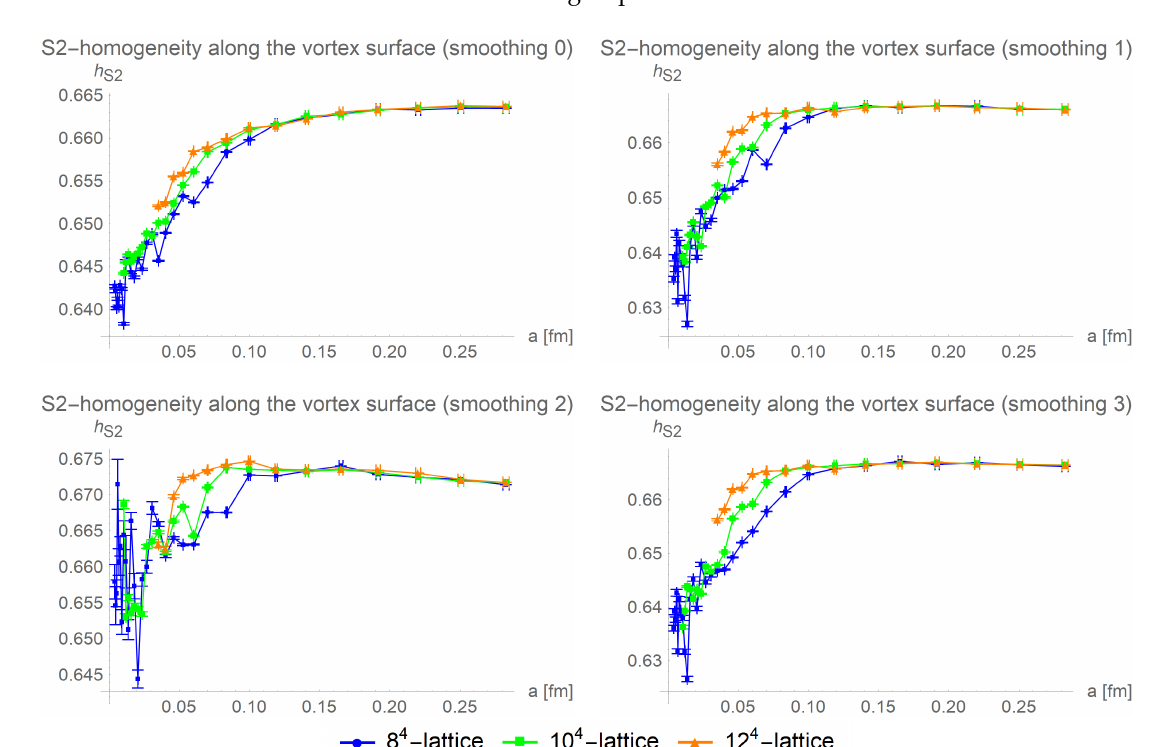
Figure 8. Averaged over 100 configurations, the S2-homogeneity along the vortex surface is compared for different lattice sizes and smoothing procedures. With increasing lattice size, the curves shift to smaller lattice spacing, indicating finite size effects.